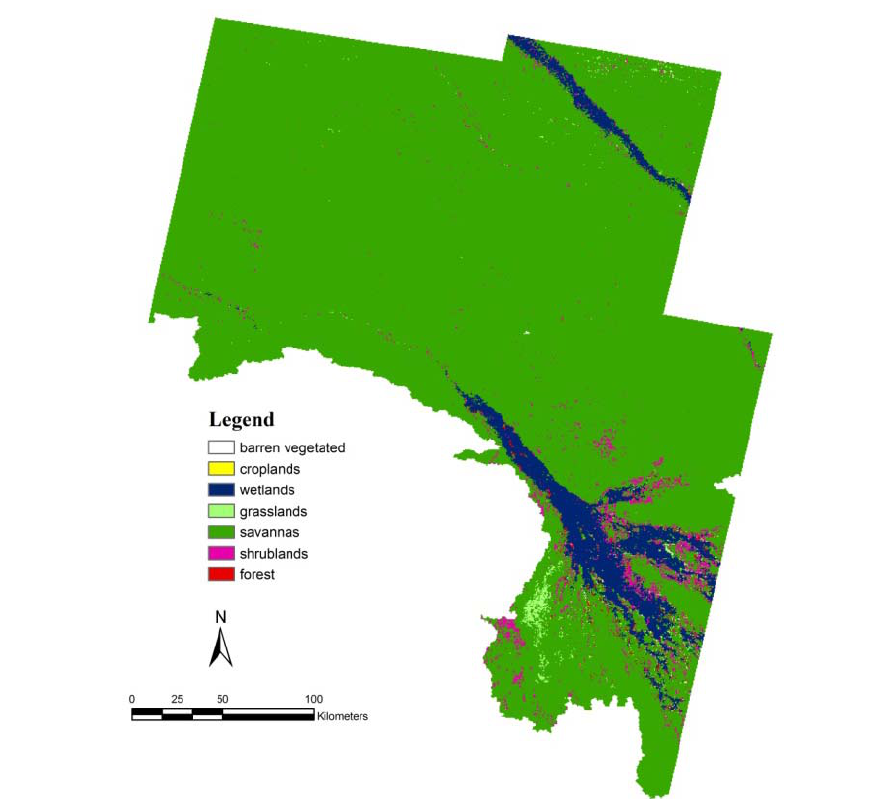
Figure 2. Land cover classification for the study region as determined by the IGBP classification